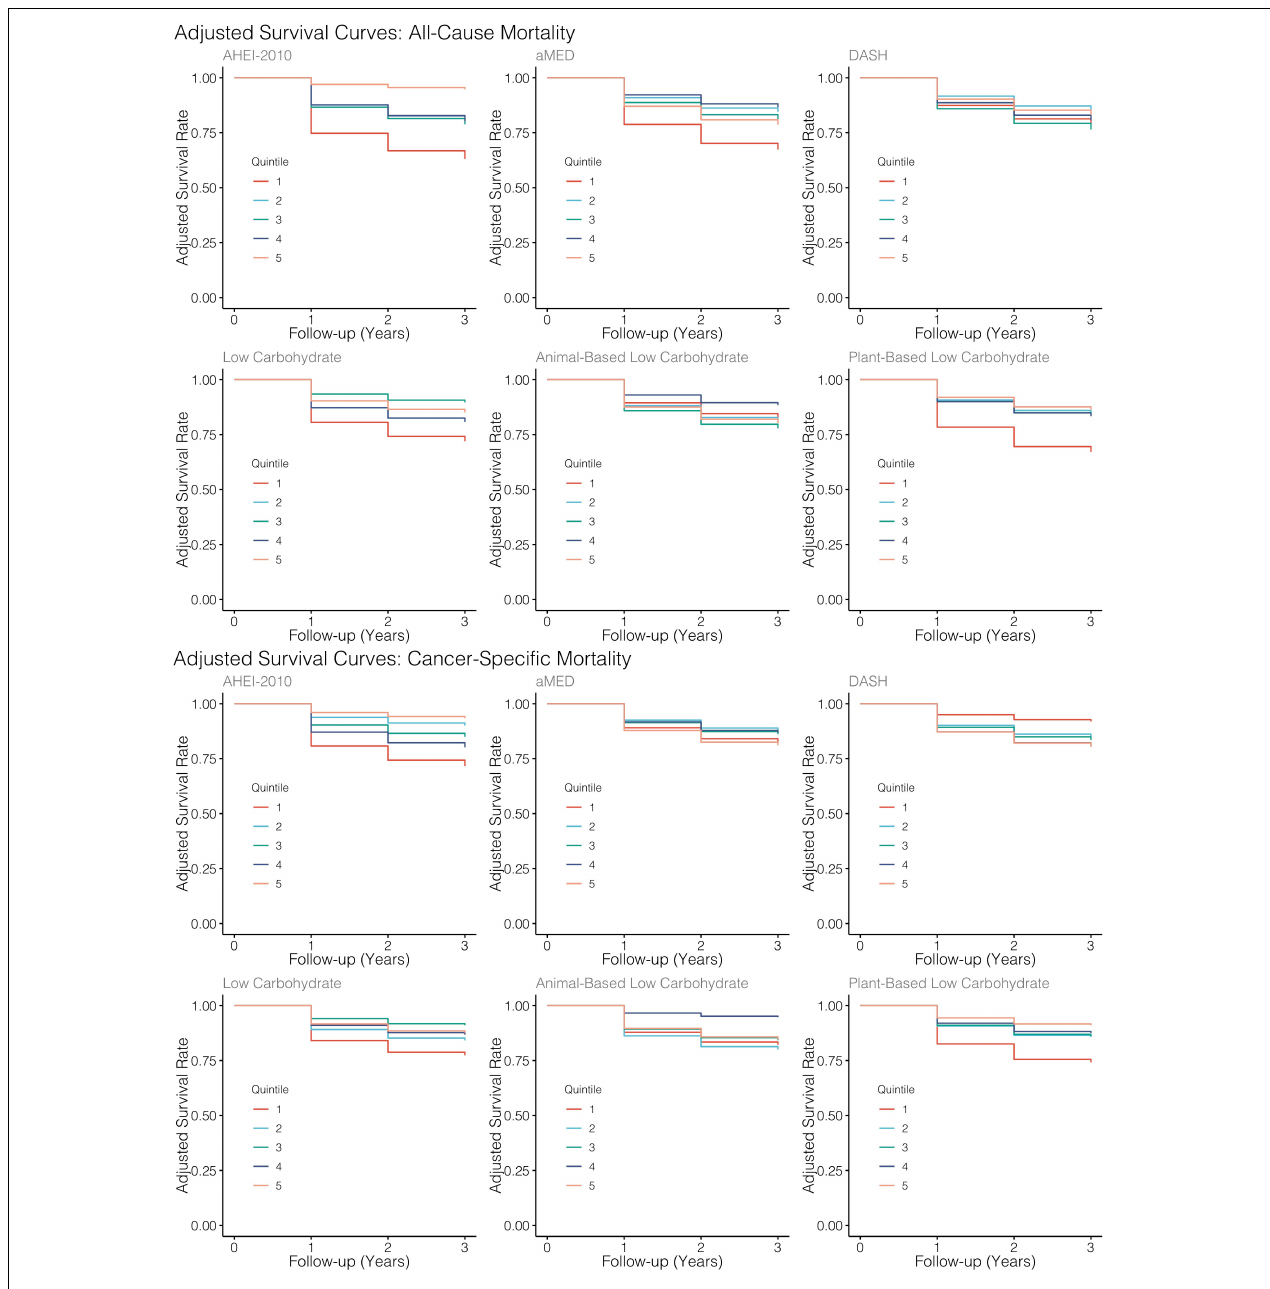
FIGURE 4 | Adjusted survival curves generated from MSMs for each diet quality index. All models adjusted for baseline age, sex, tumor site, stage, HPV status, treatment modality, ACE-27, the highest level of education attained, index score measured at the previous encounter, smoking status, caloric intake, and